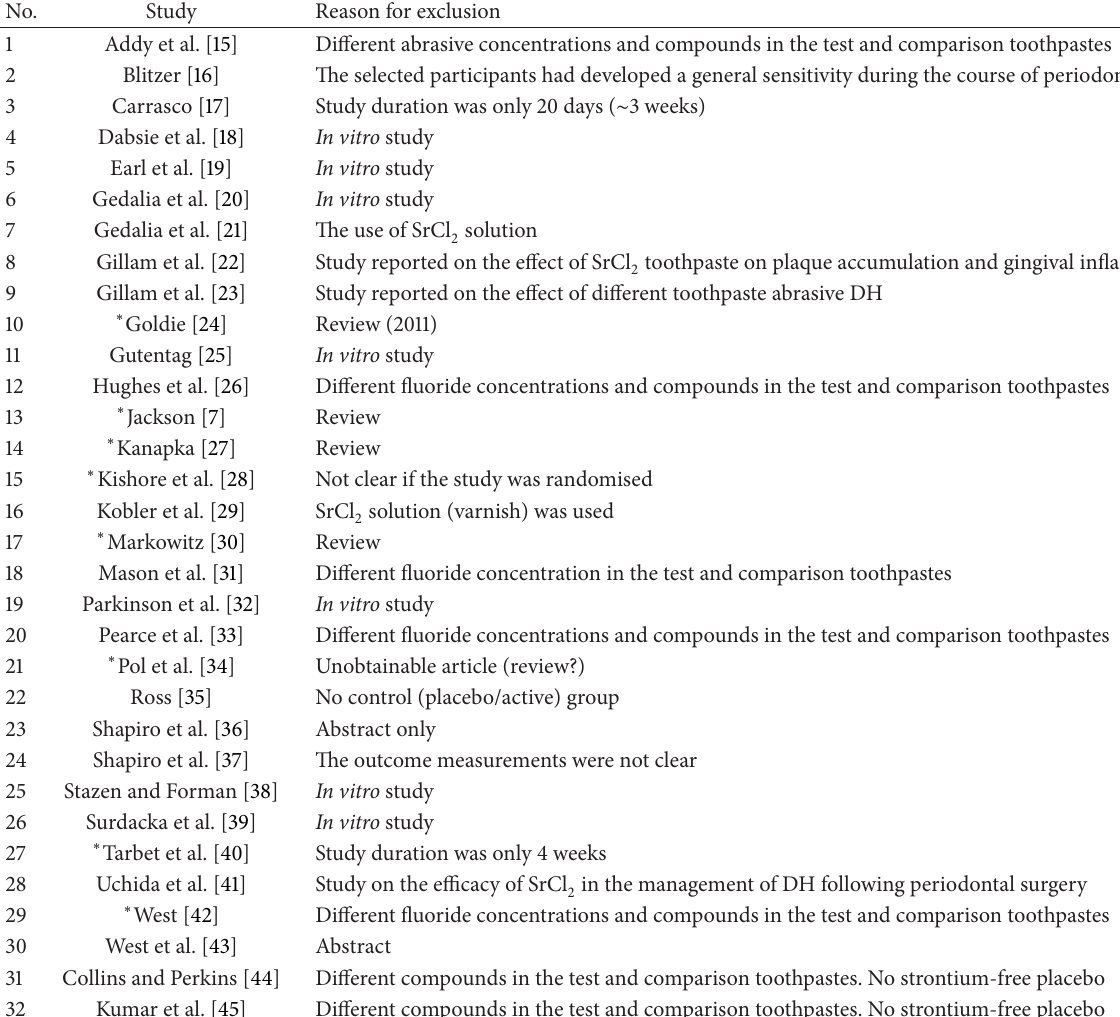
Table 1: Characteristics of Strontium-based toothpastes excluded studies